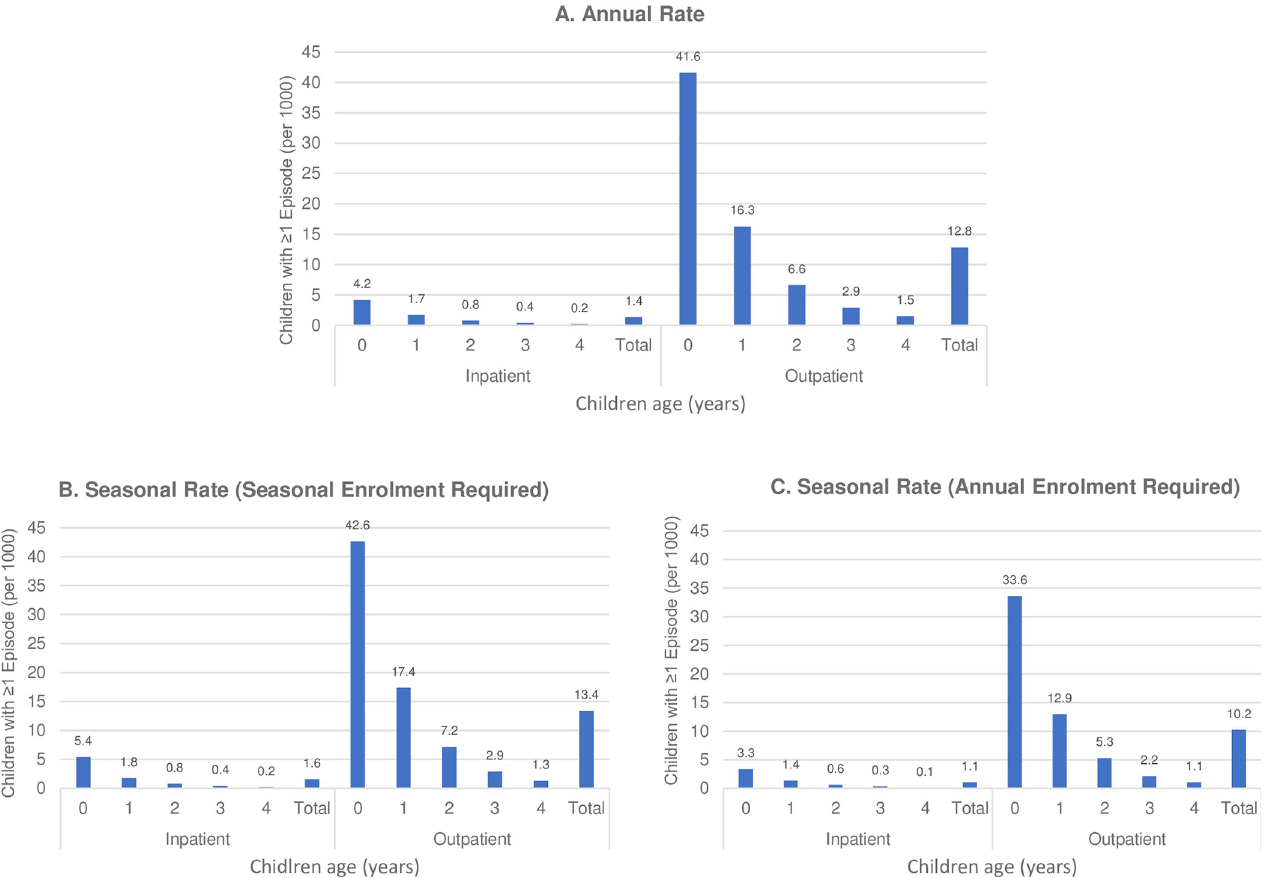
Fig 1. Respiratory syncytial virus infection rate involving inpatient or outpatient care among commercially-insured children 0–4 years, 2011–2019. A. annual rate (children age as of July 1), B. seasonal rate (constrained to November to February, children age as of November 1), C. seasonal rate estimated in the annual cohort (children age as of July